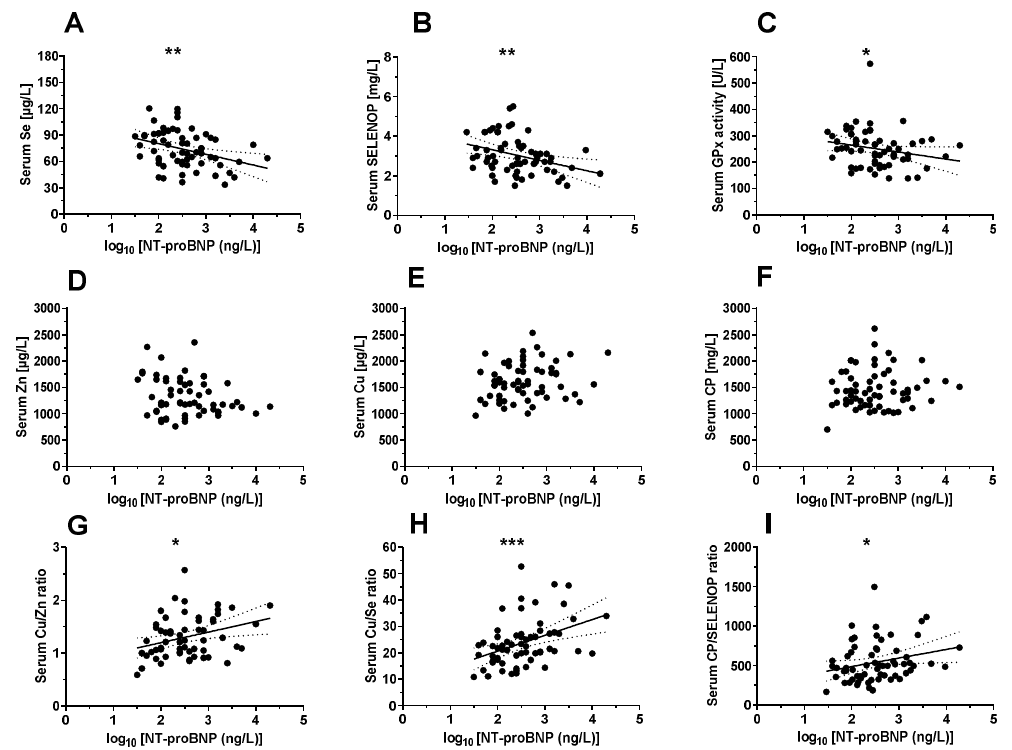
Figure 3. Biomarkers of TE status in relation to normalized NT-proBNP level. A comparison of the biomarkers of TE status to an established biomarker of SSc-PAH reveals significant interactions for most of the TE parameters analysed. Among the biomarkers of Se status, ( A ) serum Se (n = 63, r = −0.351, p = 0.005) and, ( B ) SELENOP concentrations (n = 63, r = −0.344, p = 0.006), as well as ( C ) serum GPx3 activities (n = 63, r = −0.318, p = 0.011) show a significant and consistent negative correlation with